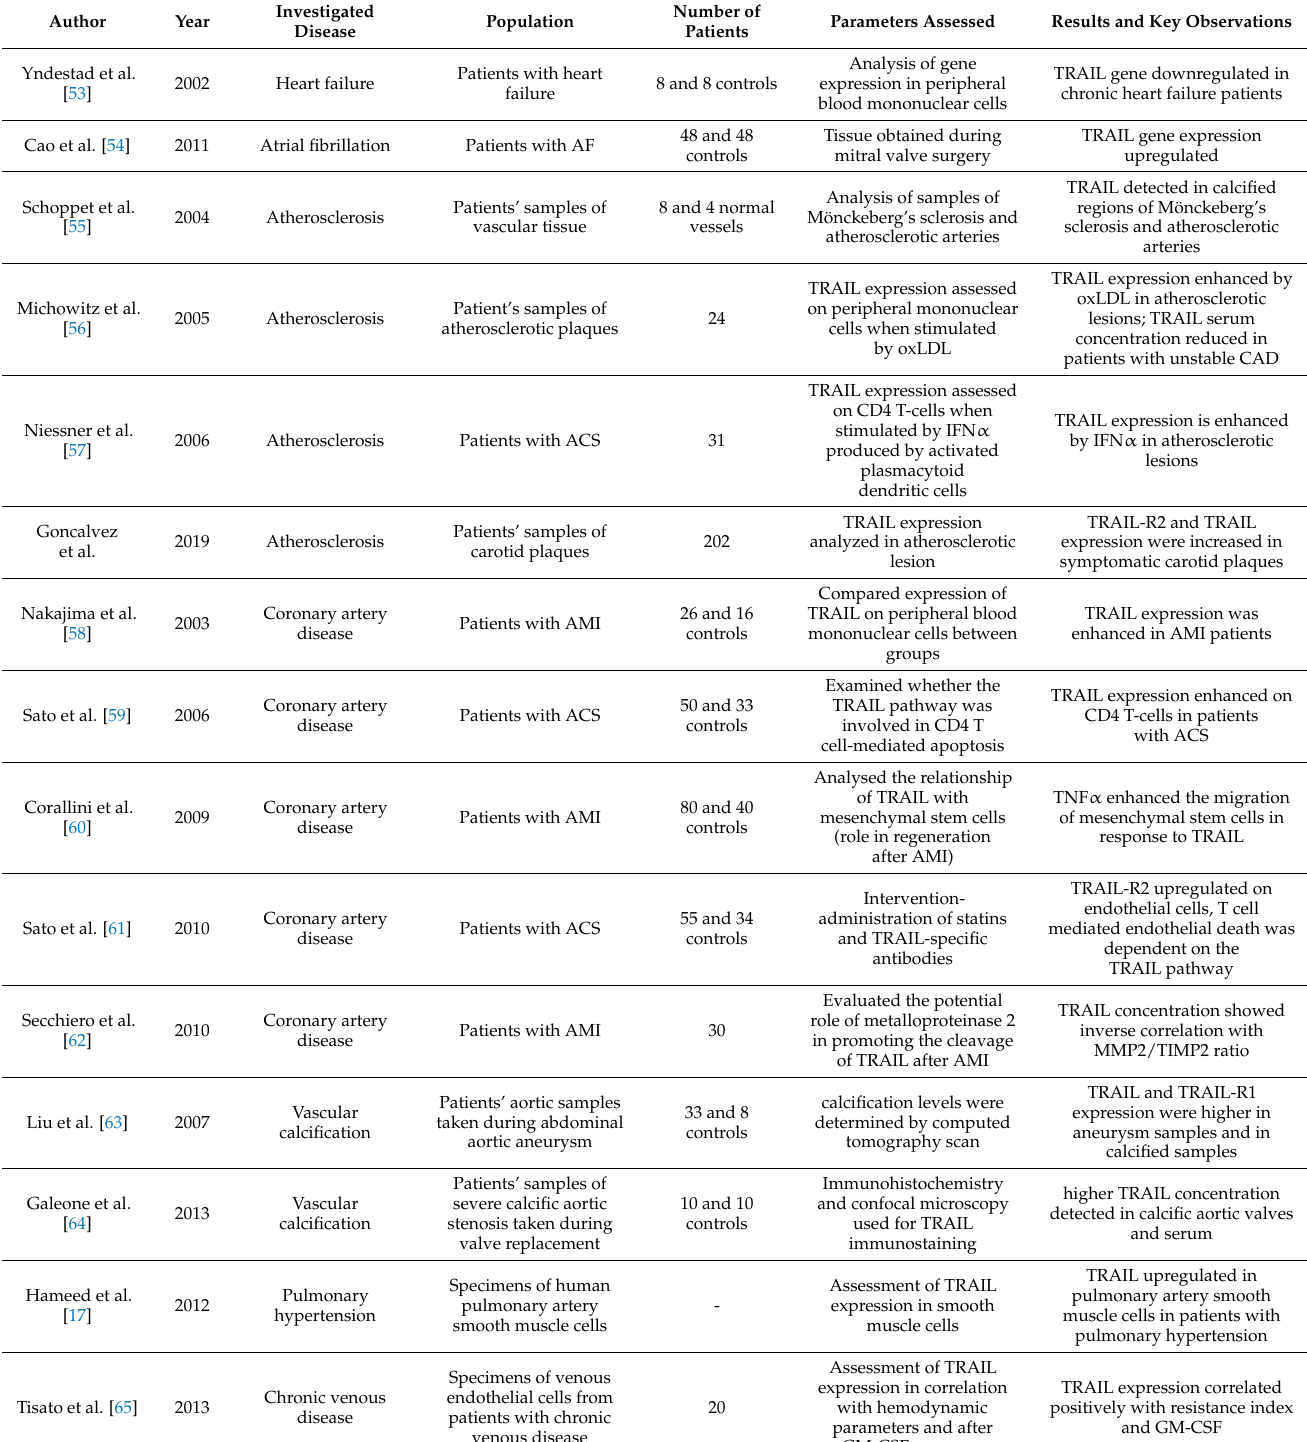
Table 2. In Vitro Studies on Human Samples Assessing Role of TRAIL and TRAIL Receptors in Cardiovascular